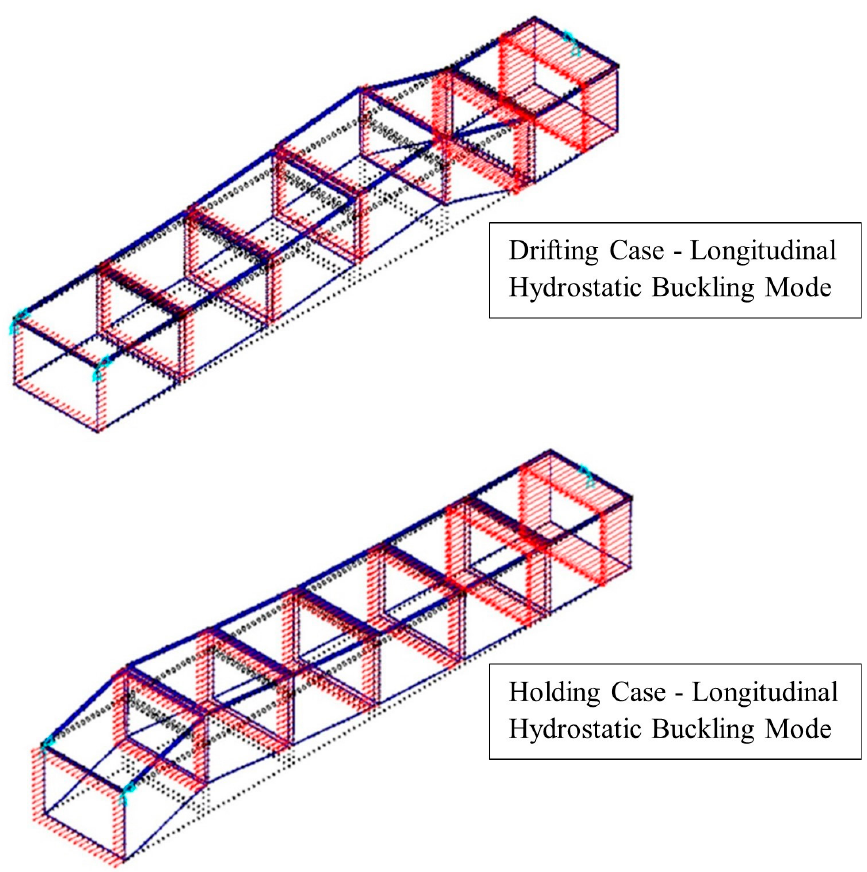
Figure 9. First longitudinal Hydrostatic Buckling mode for the six–cages system, in the Drift State (upper sub figure) and the Holding State (lower sub figure). The initial geometry is shown in doted black, the system’s elements, in proportional size, are in dark blue, the constraints are in a lighter blue and the drag (and reacted inertia in the Drift State) loads are shown by red arrows.